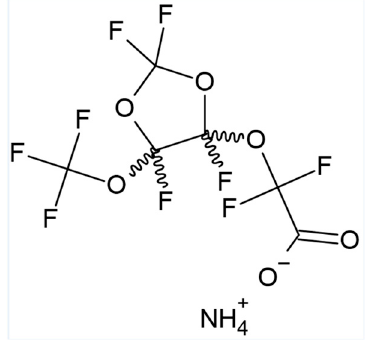
Figure 1. Molecular structure of cC 6 O 4 .